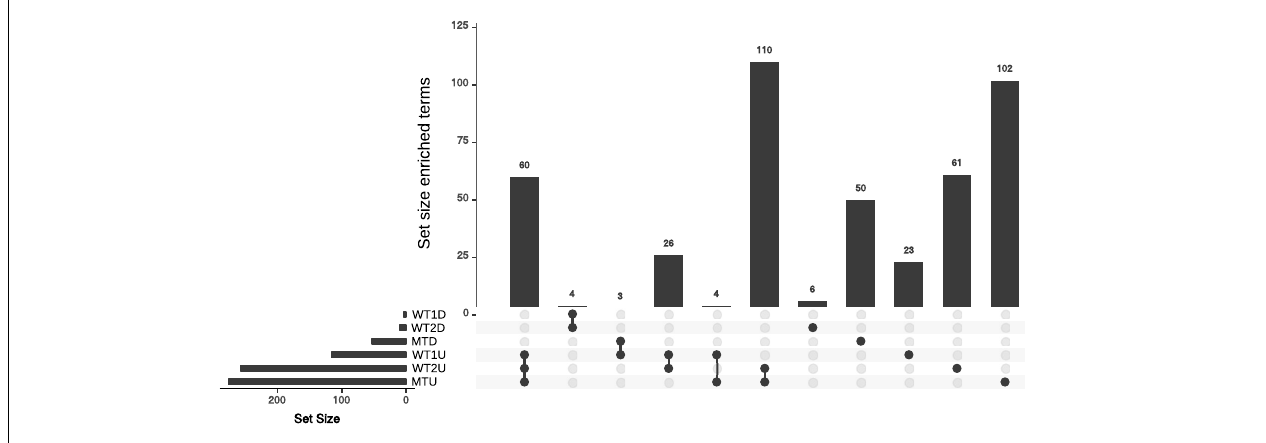
FIGURE 3 | Upset plot for the sets of enriched annotation for the skin experiments. Set of enriched annotations found in the WT1, WT2, and MT. U and D represent the set of enriched annotation for the up- and down-regulated genes,